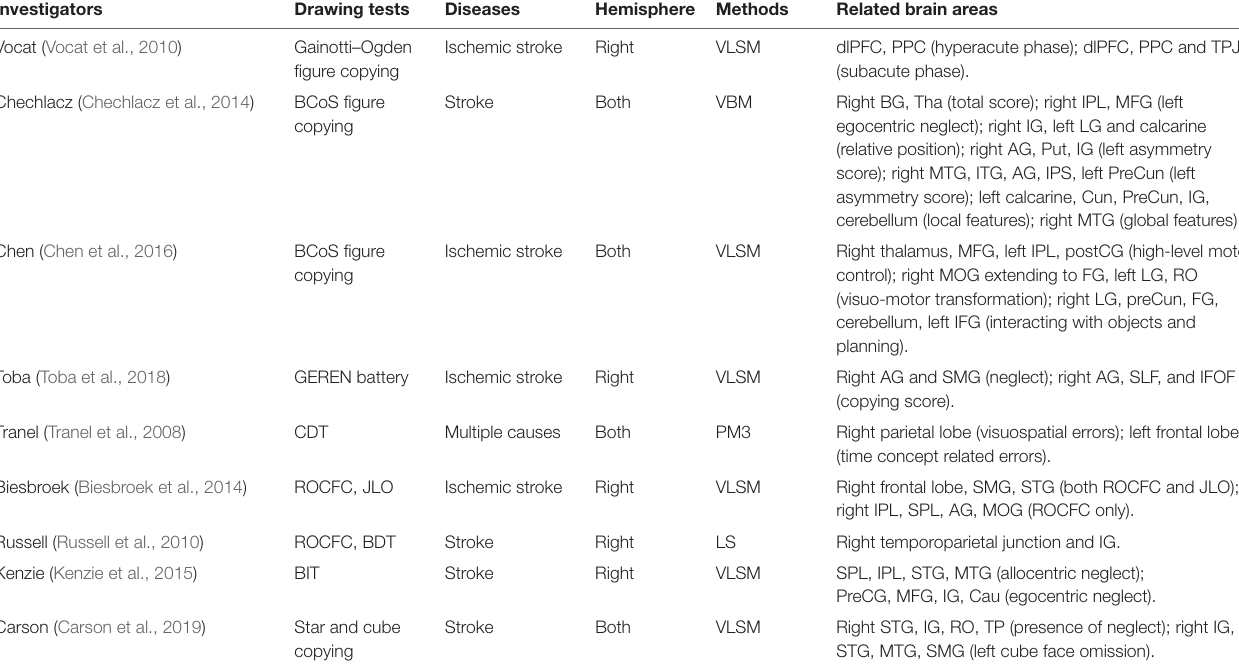
TABLE 4 | Correlations between the PPC and drawing deficits in patients with focal brain